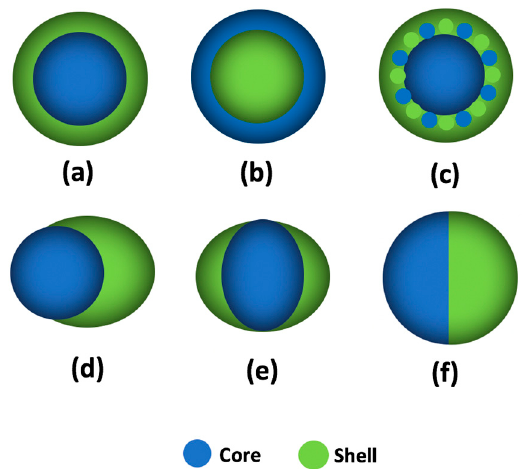
Figure 4. Schematic of fluoropolymer particles: ( a ) core–shell structure; ( b ) inverted core–shell structure; ( c ) triple-layer structure, the middle-layer contains a mixture of core monomer and shell monomer; ( d ) acorn-shaped structure; ( e ) egg-shaped structure; and ( f ) Janus-shaped structure.